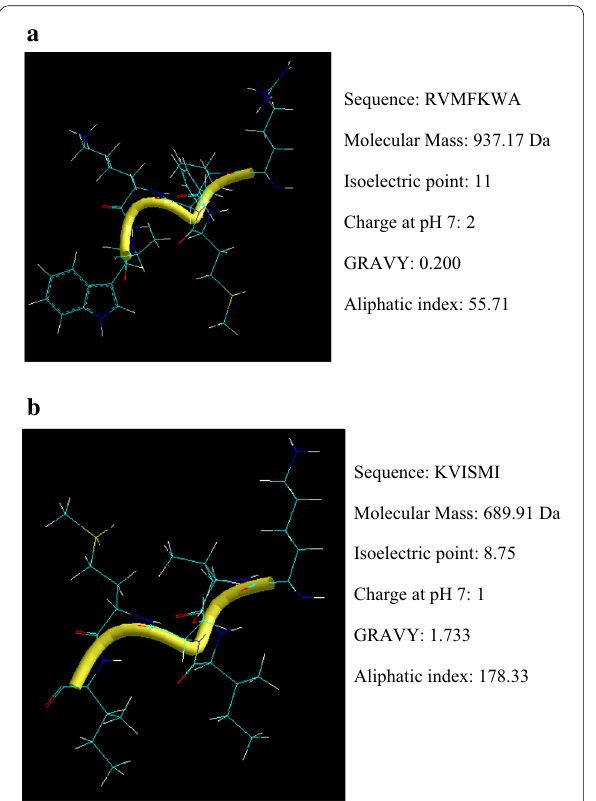
Fig. 3 Structural characterization information and the theoretical structure of antimicrobial peptides. a “RVMFKWA”; b “KVISMI” Fig. 4 Hemolysis of antimicrobial peptides. a “RVMFKWA”; b “KVISMI”. C1: control 1, Triton X-100 instead of the antimicrobial peptide; C2: control, PSB instead of the antimicrobial